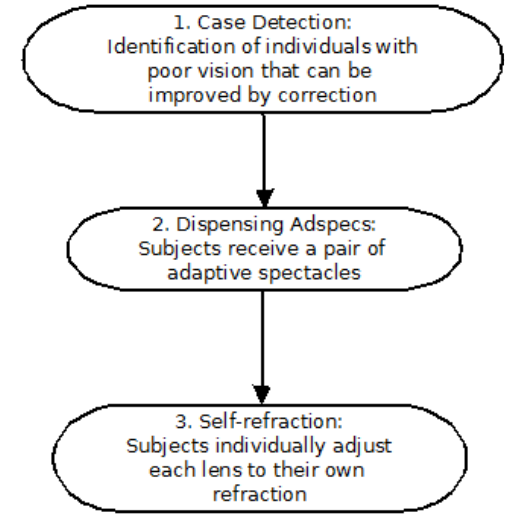
Figure 2. Adaptive spectacles self-refracting